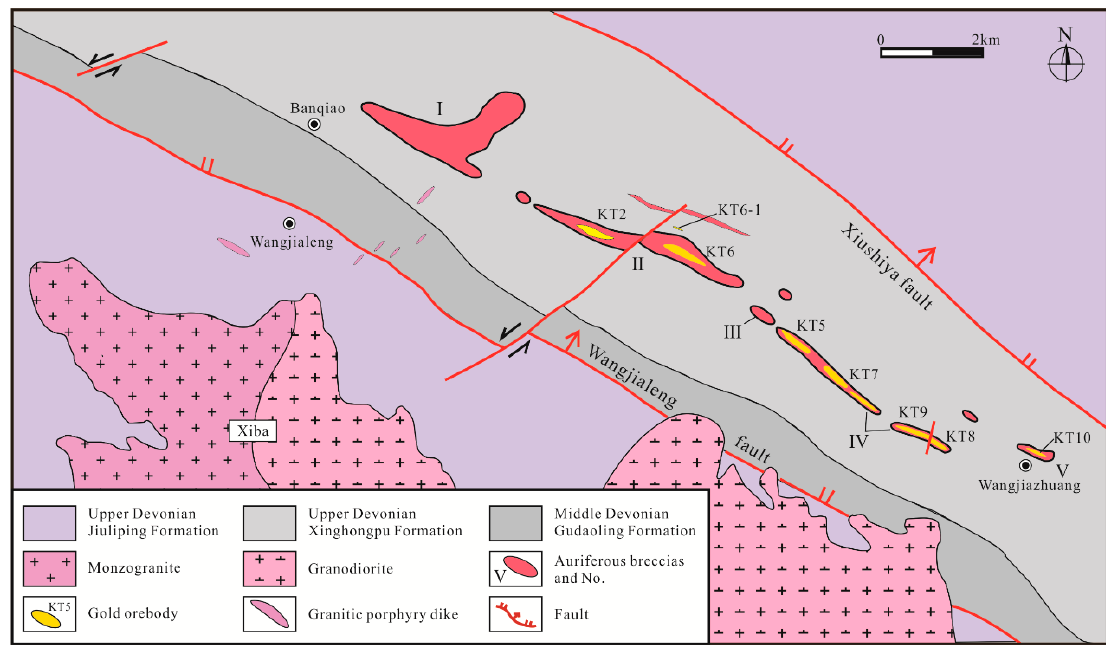
Figure 2. Sketch map of geology and deposits in the Feng-Tai ore concentration area (modified after